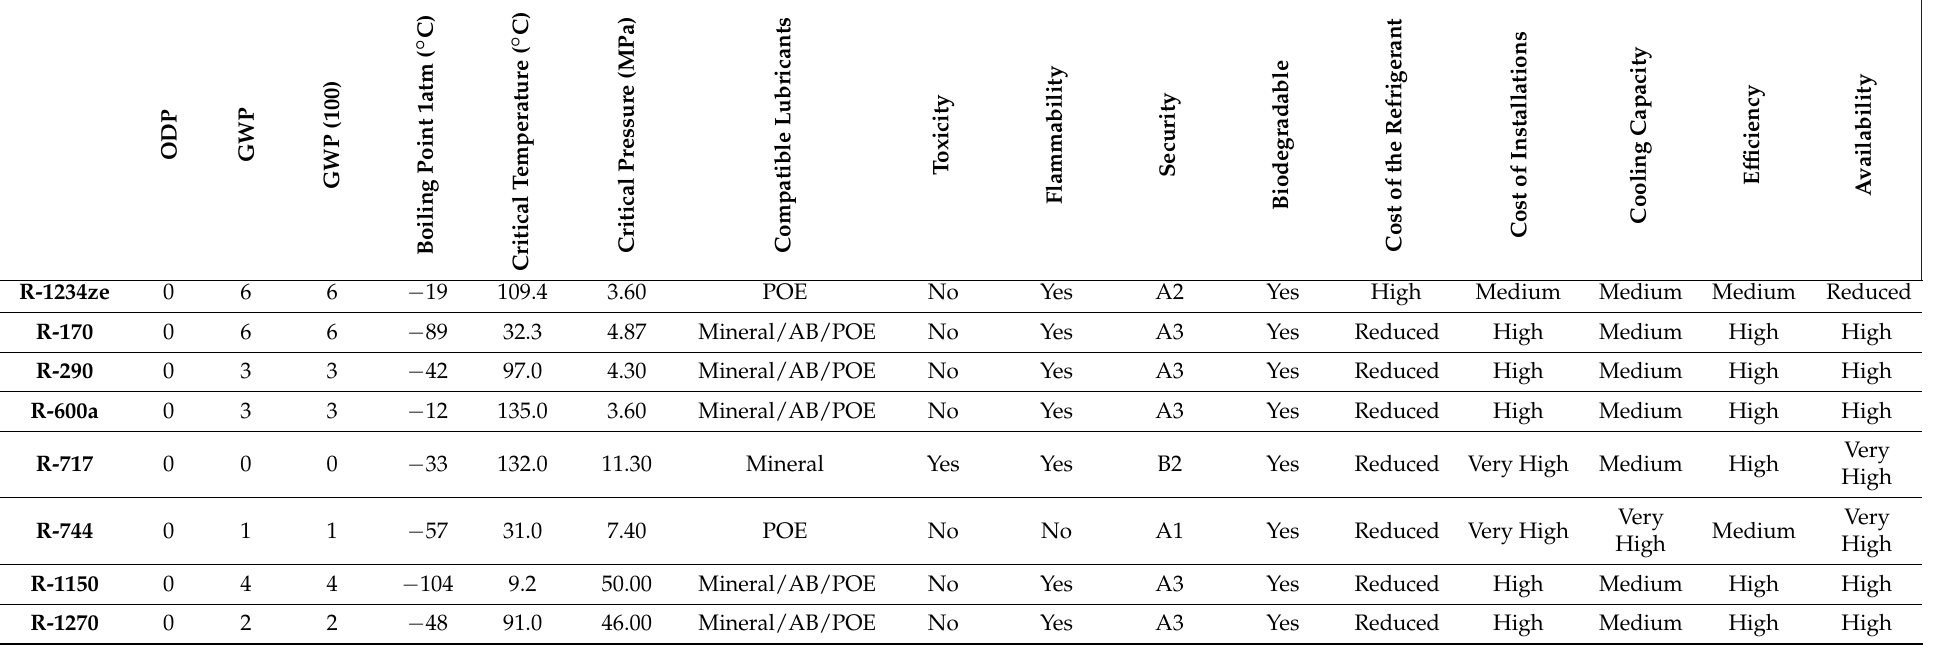
Table 4. Thermodynamic properties of alternative and/or sustainable